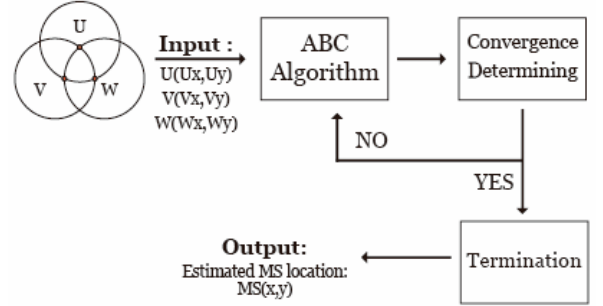
Figure 2. Main procedures of the proposed artificial bee colony (ABC)-based algorithm.